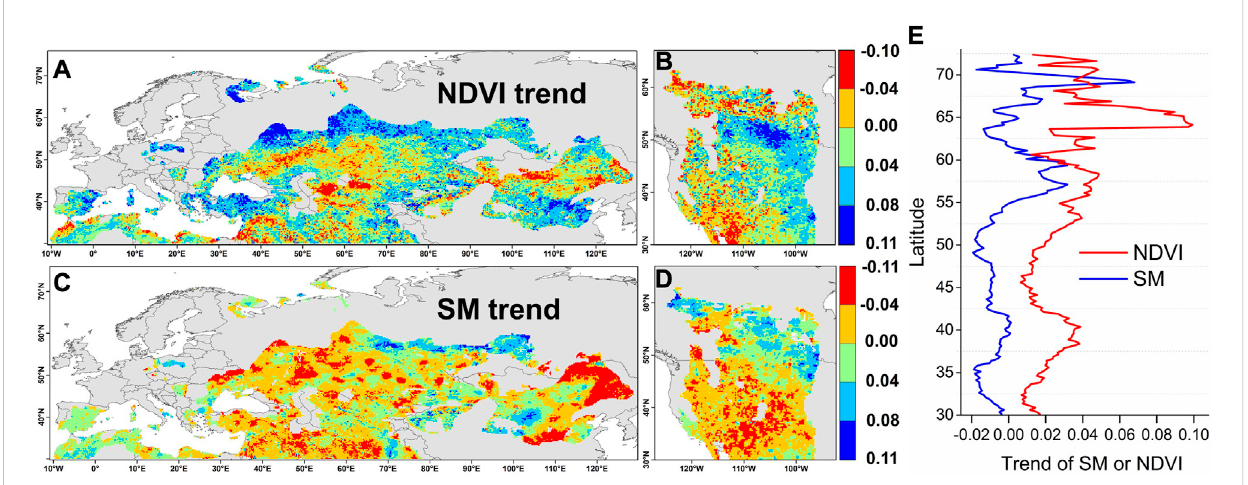
FIGURE 1 (A, B) Spatiotemporaltrend ofthe normalized difference vegetation index (NDVI) and soilmoisture (SM) inthedrylands of theNorthern Hemisphere from 1982 to 2010 and (C,D) The spatial distribution trend of the NDVI and SM, respectively. (E) The average trend of the NDVI and SM per pixel per continent in the different